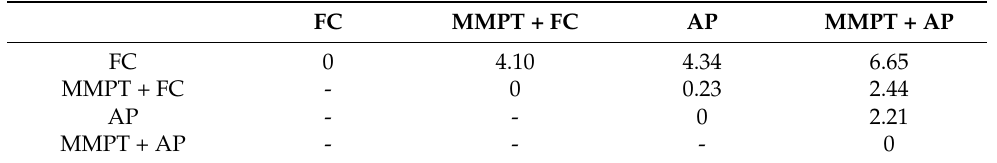
Table 6. Results of the ablation study. Relative performance improvements (%) of each component in terms of F1. MMPT = Multi-modal pre-training, FC = Fully-connected, AP = Attentive pooling.